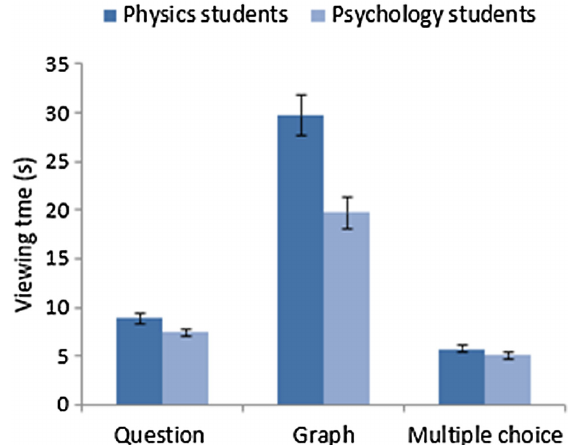
FIG. 6. Average viewing time of physics and psychology students on the AOIs Question , Graph , and Multiple choice . The error bars represent 1 SEM.